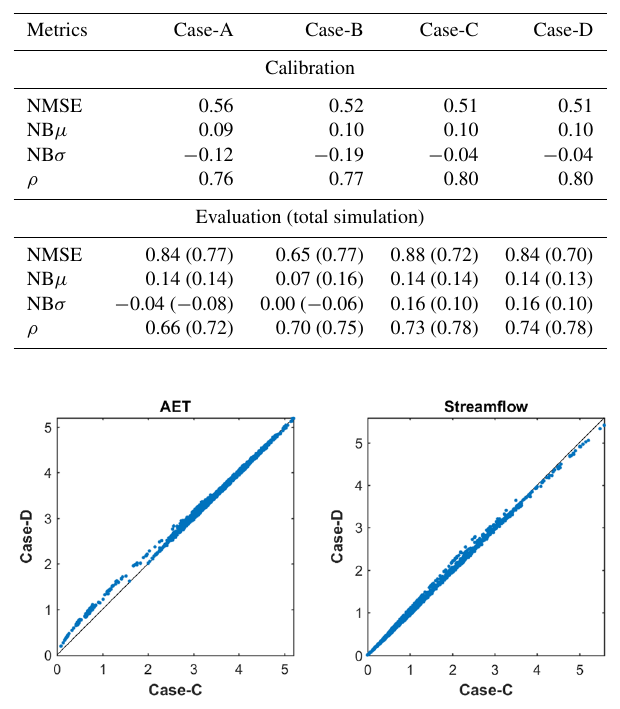
Figure 8. Scatter plots of streamflow and AET from Case-C and Case-D.